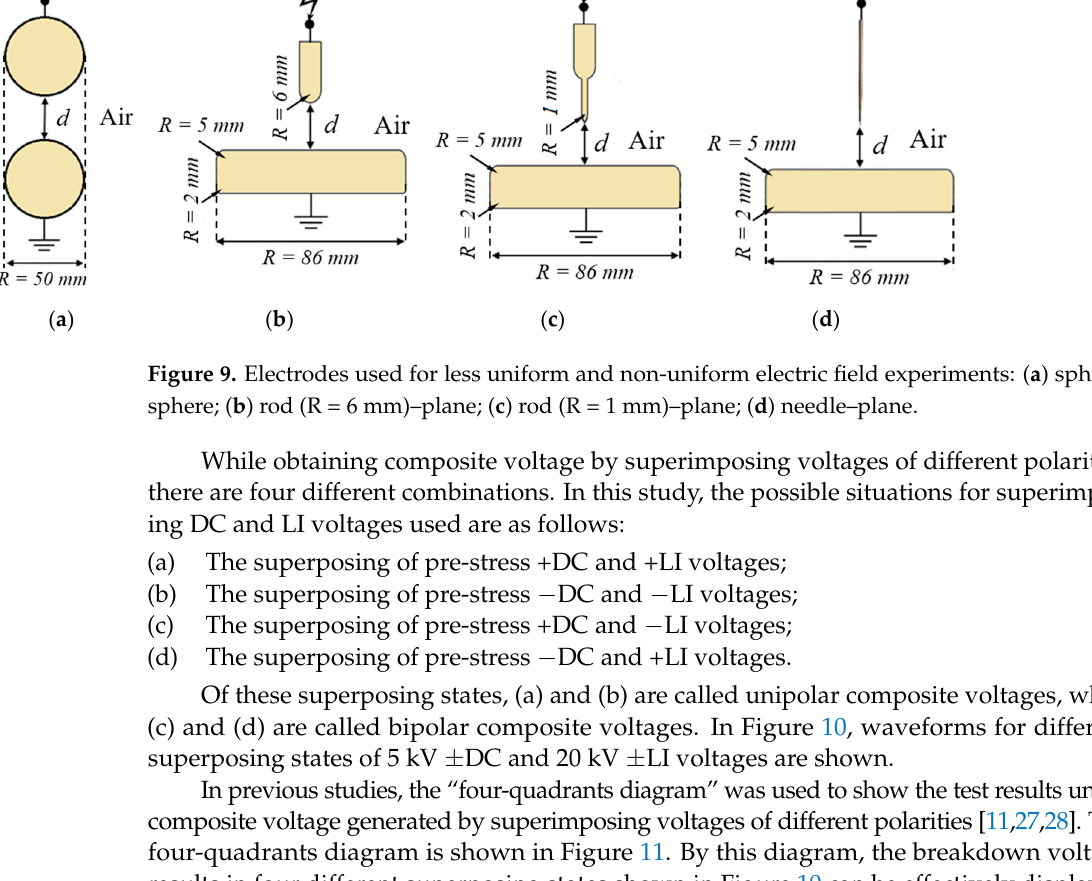
Figure 8. ( a ) The voltage at input and output of coupling capacitor; ( b ) CV generated on the exper- imental setup.